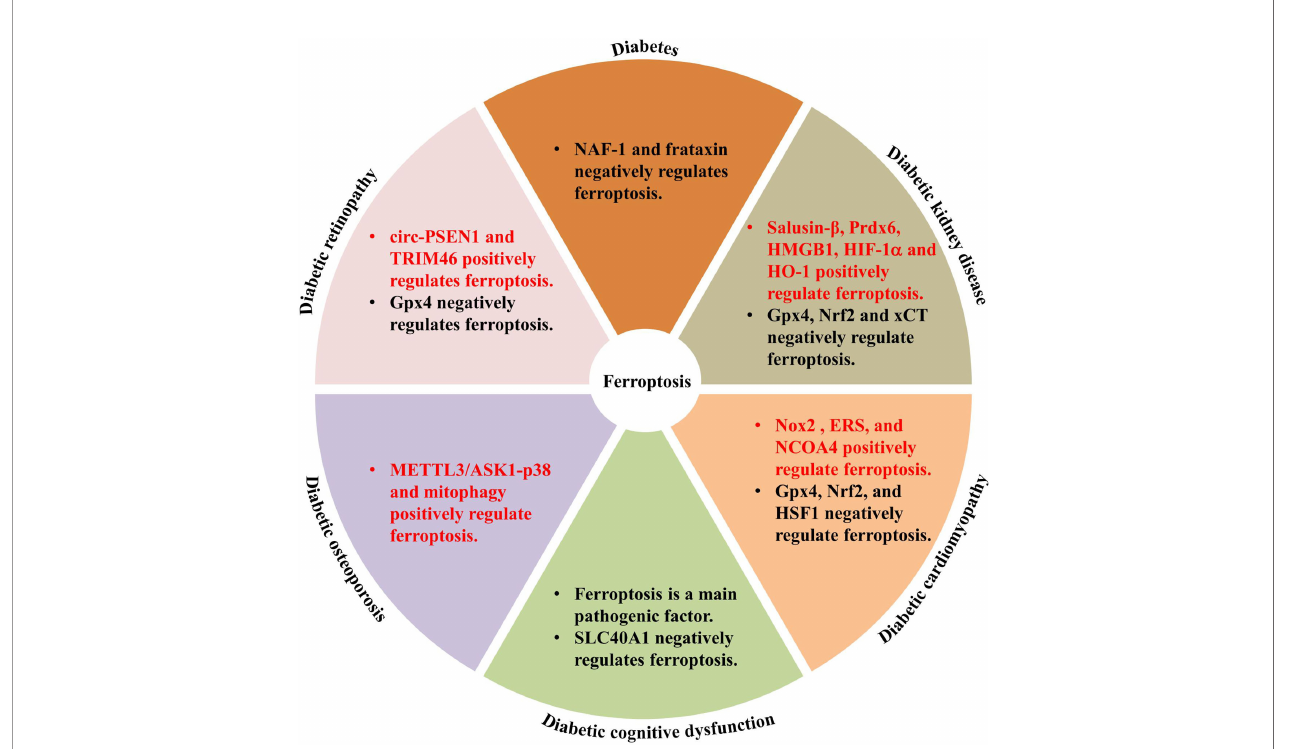
FIGURE 2 | Genes involved in ferroptosis regulation in diabetes and diabetic